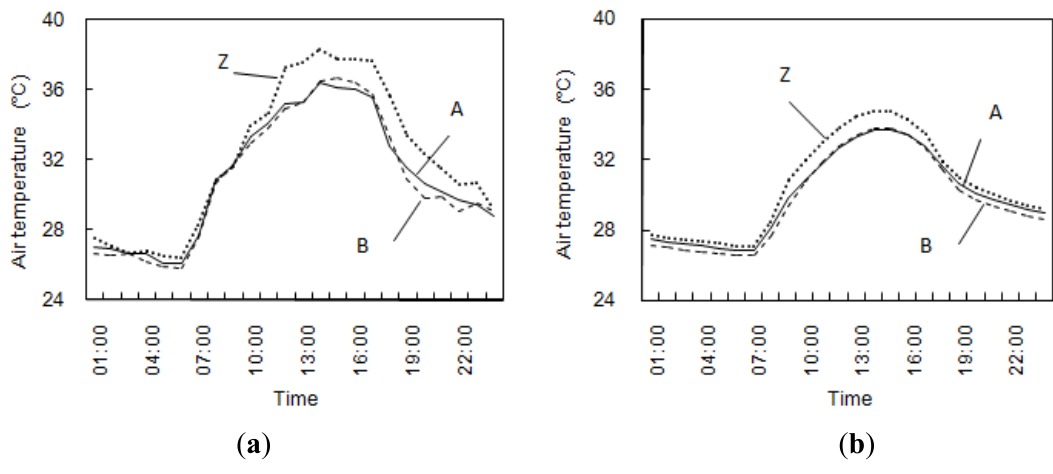
Figure 4. Correlations between the hourly-based observed and simulated air